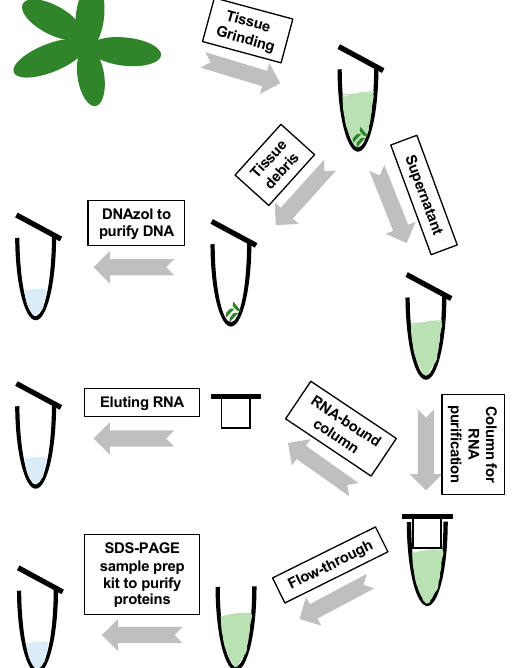
Figure 4. A flow chart demonstrating the procedures to co-purify DNA, RNA, and proteins.